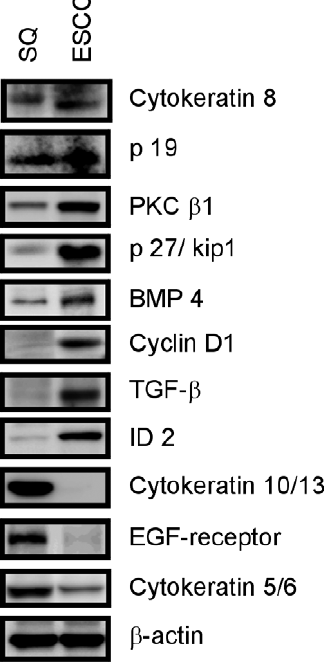
Fig. 5. Immunoblot validation of SAGE results of esophageal squa- mous cell carcinoma and normal squamous esophagus. Immunoblot analysis on protein samples from esophageal squamous cell carci- noma and normal squamous esophagus biopsies from different pa- tients reveals that Cytokeratin 8, p19, PKC- β 1, p27/kip, BMP4, Cy- clin D1, TGF- β and ID2 are highly expressed in esophageal squa- mous cell carcinoma (ESCC) and lower in normal squamous esopha- gus (SQ). Furthermore Cytokeratin 10/13, EGF-receptor and Cytok- eratin 5/6 are highly expressed in normal squamous esophagus and lower in esophageal squamous cell carcinoma. Pictures are represen- tative for results of 13